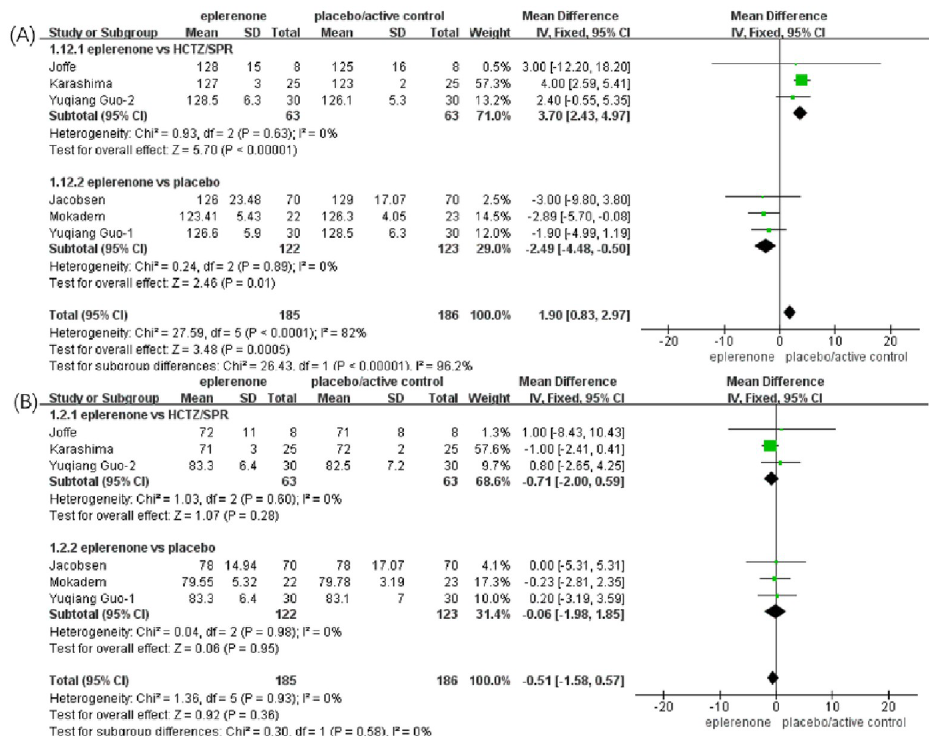
Fig 5. Forest plots of the effects between the eplerenone treatment groups and the controls. (A) Effect on SBP in articles comparing eplerenone to placebo/active control. (B) Effect on DBP in articles comparing eplerenone to placebo/active control.